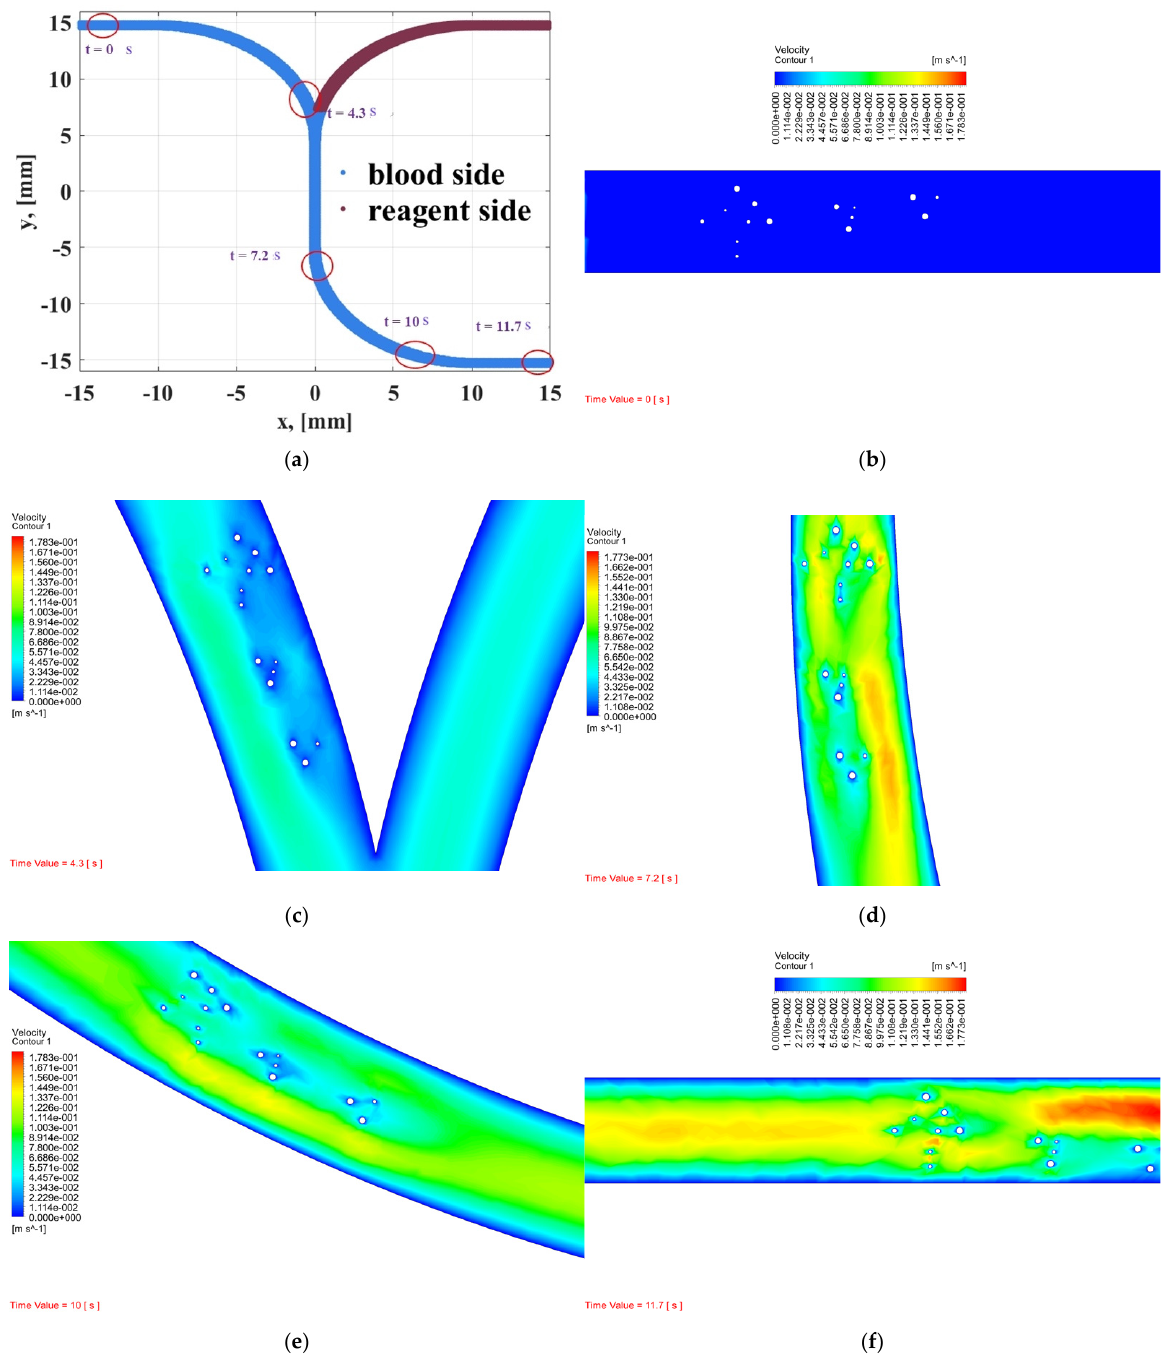
Figure 9. Dynamic behavior of WBCs and RBCs in the microchannel of ( a ) whole flow, ( b ) 0 s, ( c ) 4.3 s, ( d ) 7.2 s, ( e ) 10 s and, ( f ) 11.7 s.